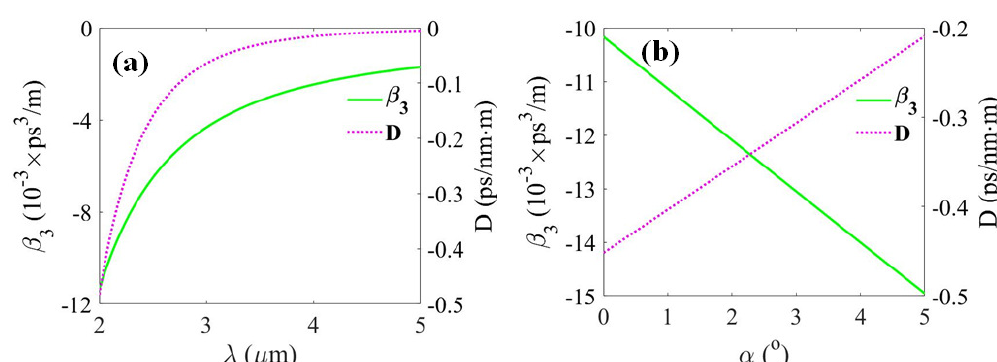
Figure 14. Third-order dispersion coefficient β 3 and dispersion constant D varying with the experimental parameters: ( a ) Varying with wavelength ( α = 0.5 ◦ ); and ( b ) varying with propagation angle ( λ = 2.05 µ m).